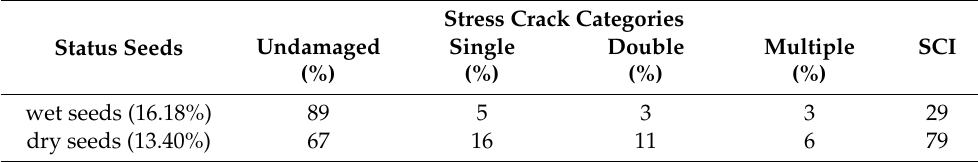
Table 2. Stress crack analysis of sampled corn before and after drying. Stress Crack Categories SCIUndamaged Single Double Multiple Status Seeds (%) (%) (%) (%) wet seeds (16.18%) 89 5 3 3 29 dry seeds (13.40%) 67 16 11 6